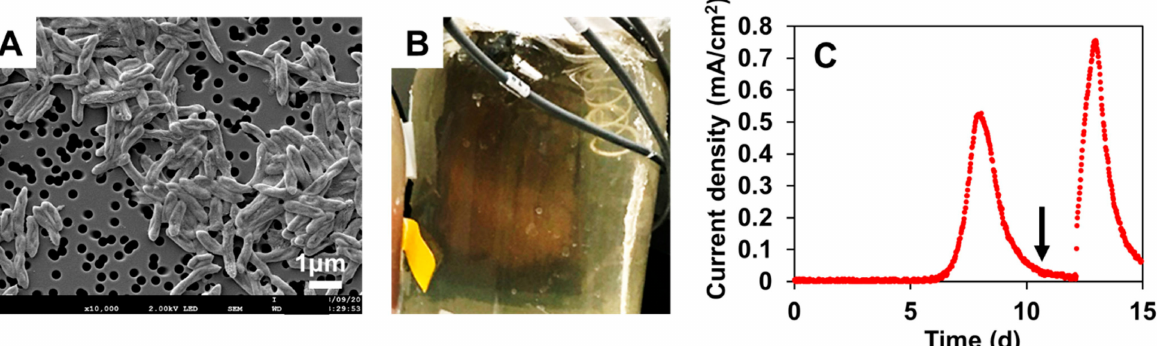
Figure 1. Morphology and electrogenic properties of strain NIT-SL11. ( A ) Scanning electron micro- scopic image of strain NIT-SL11. ( B ) Biofilm generated on an electrode in an electrochemical culture. ( C ) Electric current production by strain NIT-SL11. The arrow in panel C indicates a spike in acetate addition.